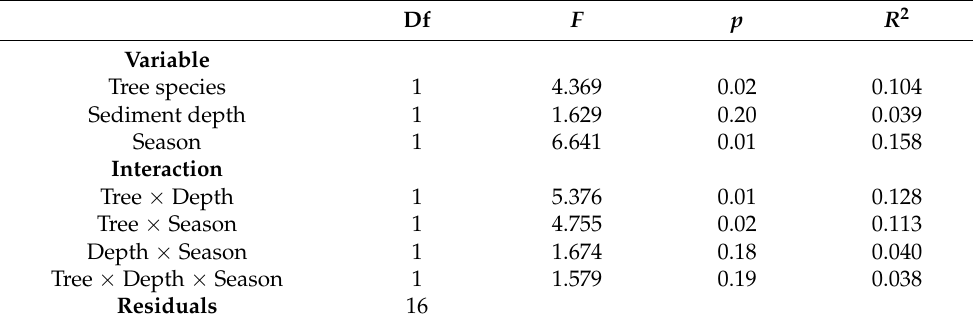
Figure 1. Diversity of expressed genes encoding xylanases in surface and deeper sediments collected beneath two tree species ( Avicennia marina and Rhizophora stylosa ) during the wet (March) and dry (November) seasons. ( A ) Diversity estimated with the Shannon index and ( B ) distribution of the different operational functional units (OFUs). Table 1. Effect of environmental factors on the composition of expressed fungal genes encoding GH 11